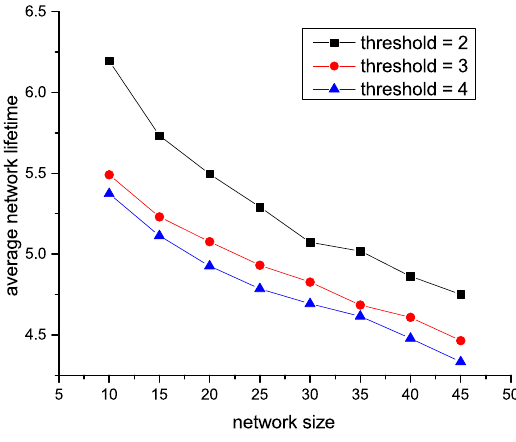
Figure 8. Effect of parameter l in distributed HAS 4 on network